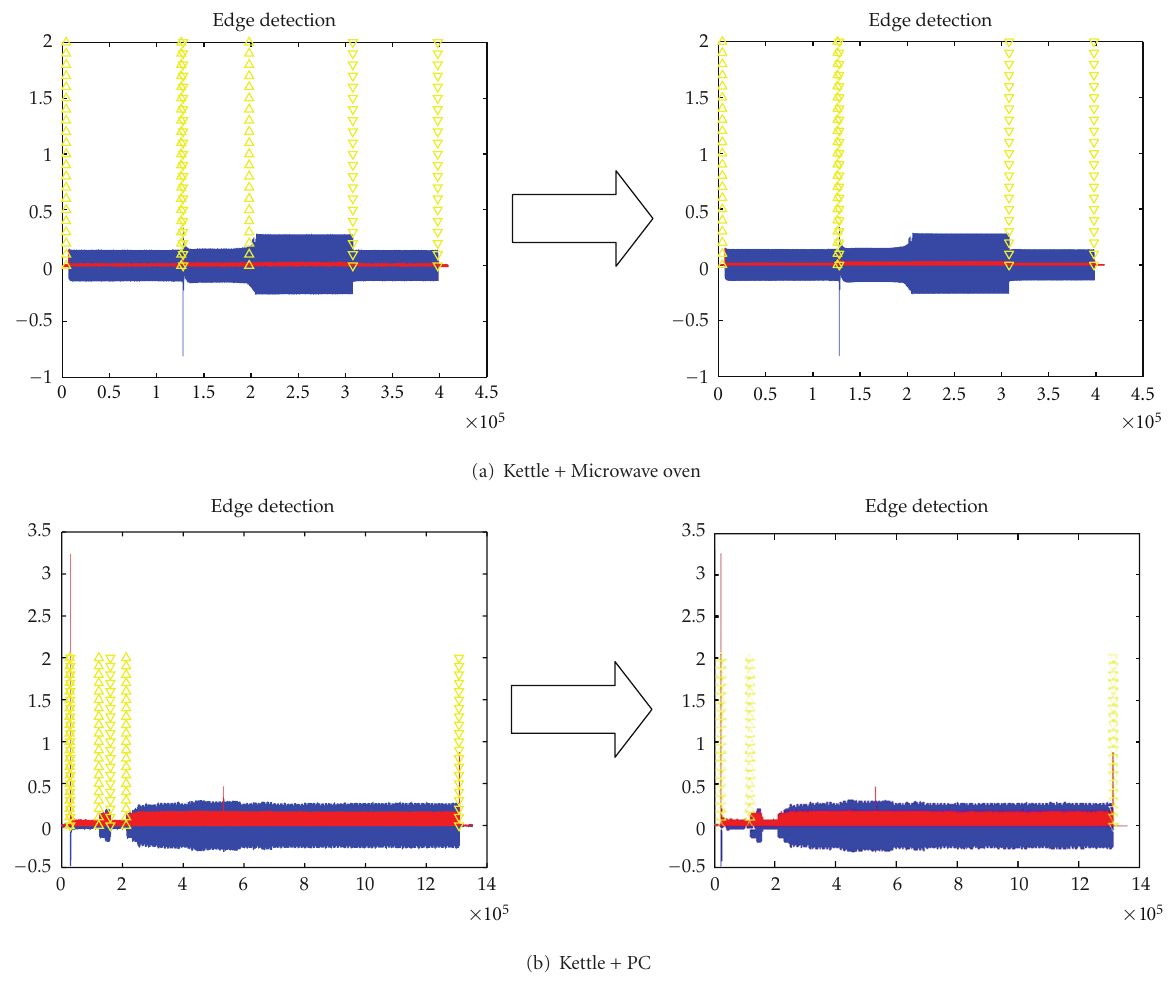
Figure 5: Examples of power signal edge analysis.